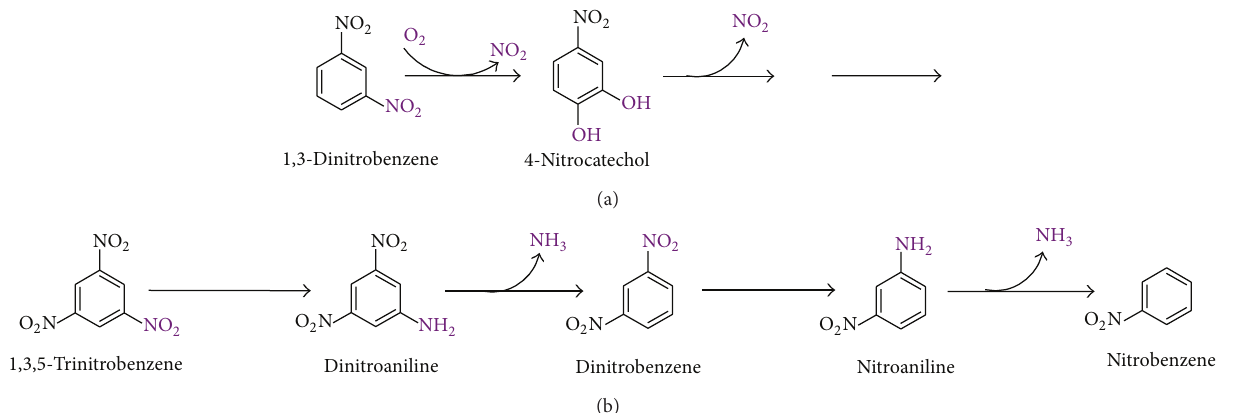
Figure 4: Degradation pathway of 1,3-dinitrobenzene (a) and 1,3,5-trinitrobenzene